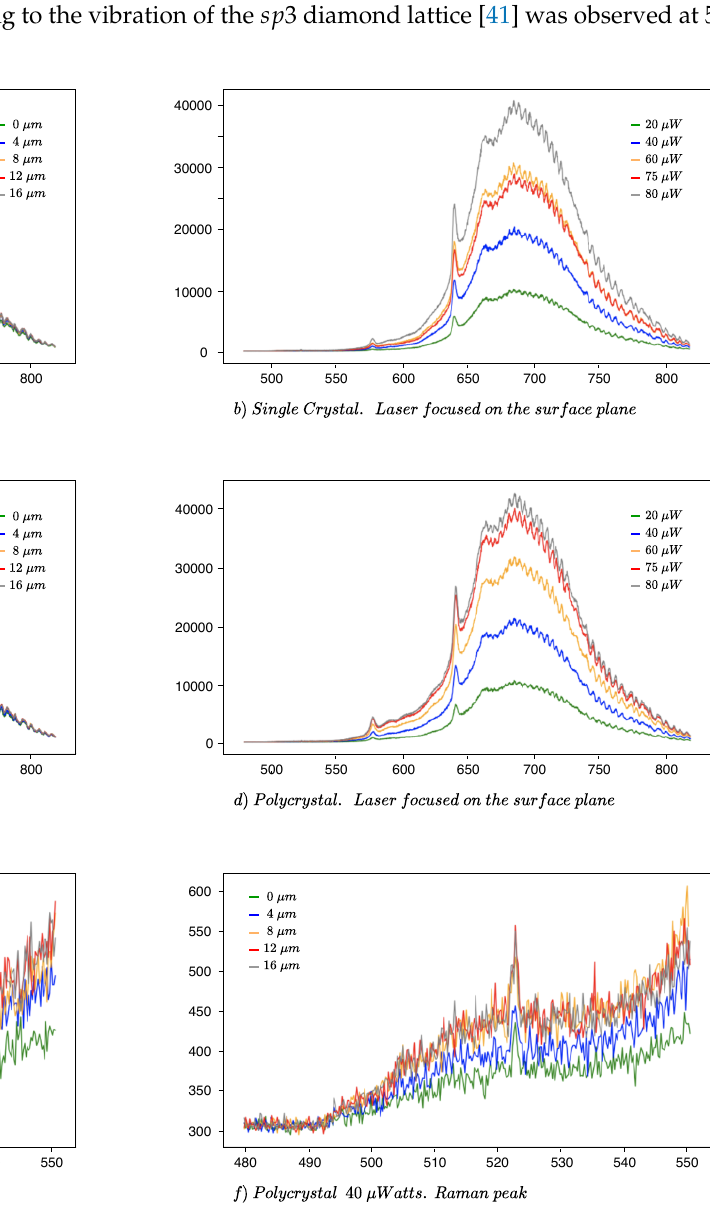
Figure A3. Photoluminescence spectra for the single crystal ( a , b ) and detail of the observed Raman peak ( e ). Photoluminescence spectra for the polycrystal ( c , d ) and detail of the observed Raman peak ( f